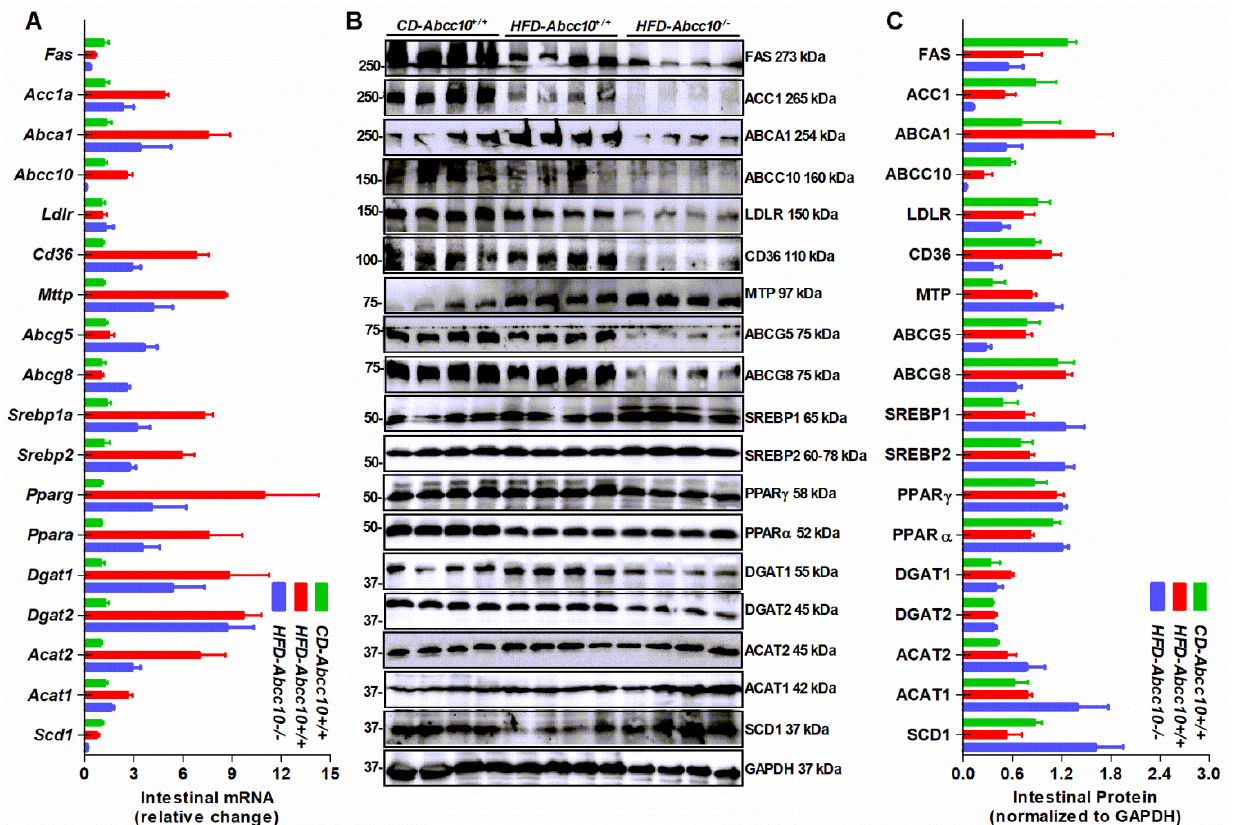
Figure 8. Expression of lipid metabolism genes in the intestine is altered in Abcc10 -gene-deleted high-fat-diet-fed mice. Eight-week-old Abcc10 +/+ ( HFD-Abcc10 +/+ , n = 4) and Abcc10 − / − ( HFD-Abcc10 − / − , n = 5) male mice were fed high-fat obesity diet for 16 weeks. As a control, age-matched Abcc10 +/+ ( CD-Abcc10 +/+ , n = 4) male mice were kept on chow diet during this period. At the end of the experiment, mice were fasted overnight and sacrificed. Intestines were used to isolate total RNA to measure the expression of genes using quantitative real-time PCR ( A ). Intestines were also homogenized and used to measure the expression of proteins by Western blotting ( B ). Density of the protein bands was quantified by using ImageJ software and the values were plotted after normalizing to the internal GAPDH control ( C ). Values are plotted as replicates (mean ± SD).